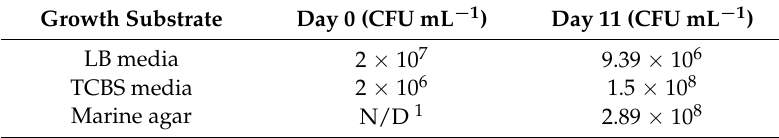
Table 2. Abundance of the bacterial background community (CFU mL − 1 ) associated with the fish eggs, in turbot challenge trial 2, and cultured on different media. Day 0: water the eggs were transported in for 24 h; Day 11: water in the wells of the live nonchallenged